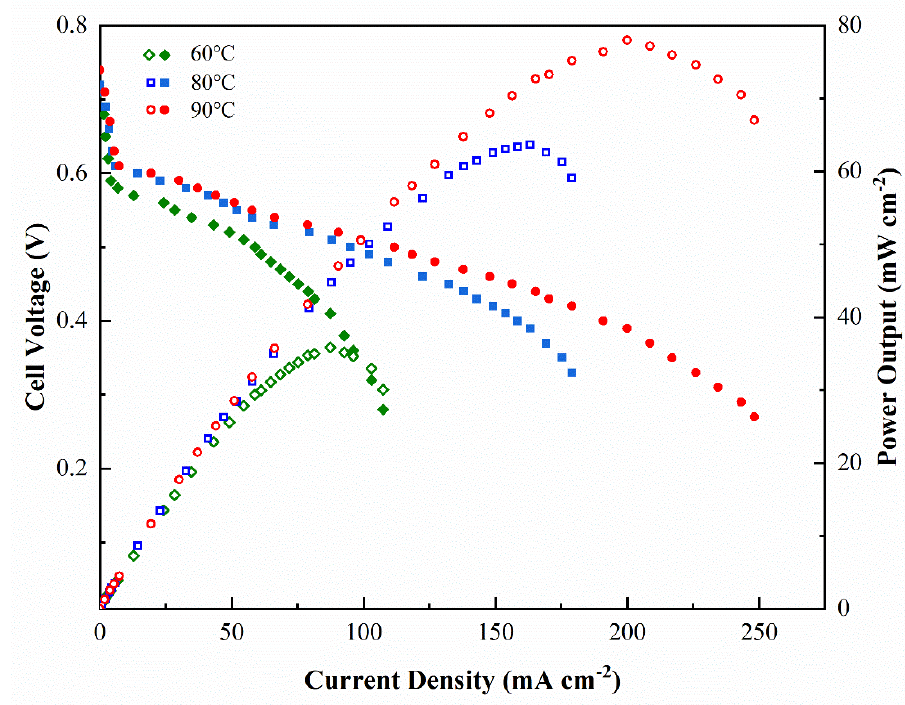
Figure 9. Effects of cell temperature on DMFC performance for SPPQ-5 with O 2 supply without humidification and press and a 5 wt% methanol feed concentration.